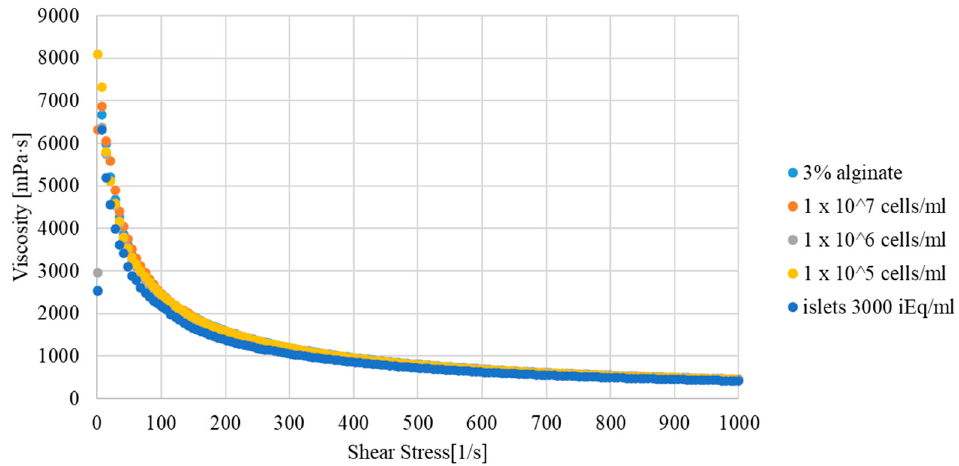
Figure 3. Viscosity curve of the hydrogel used for 3D bioprinting depending on the biological material added.